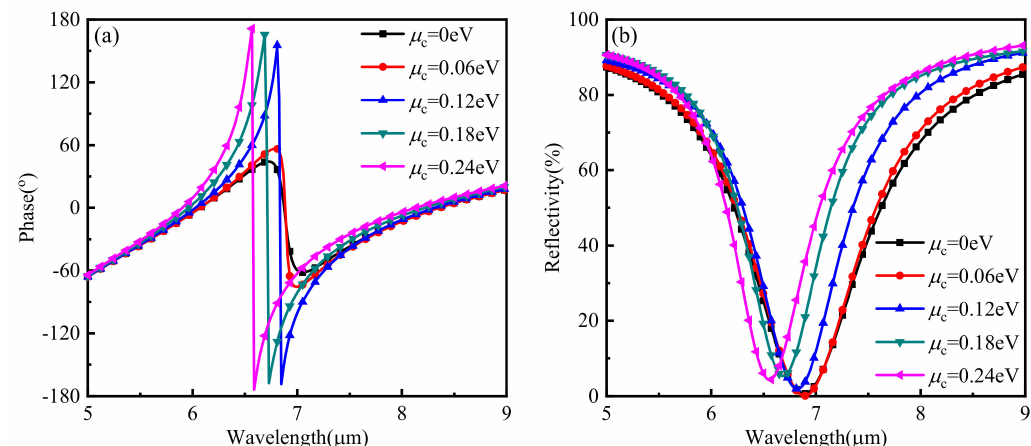
Figure 2. ( a ) Reflection phase performances with various Fermi levels of graphene. ( b ) Reflection amplitude performances with various Fermi levels of graphene.